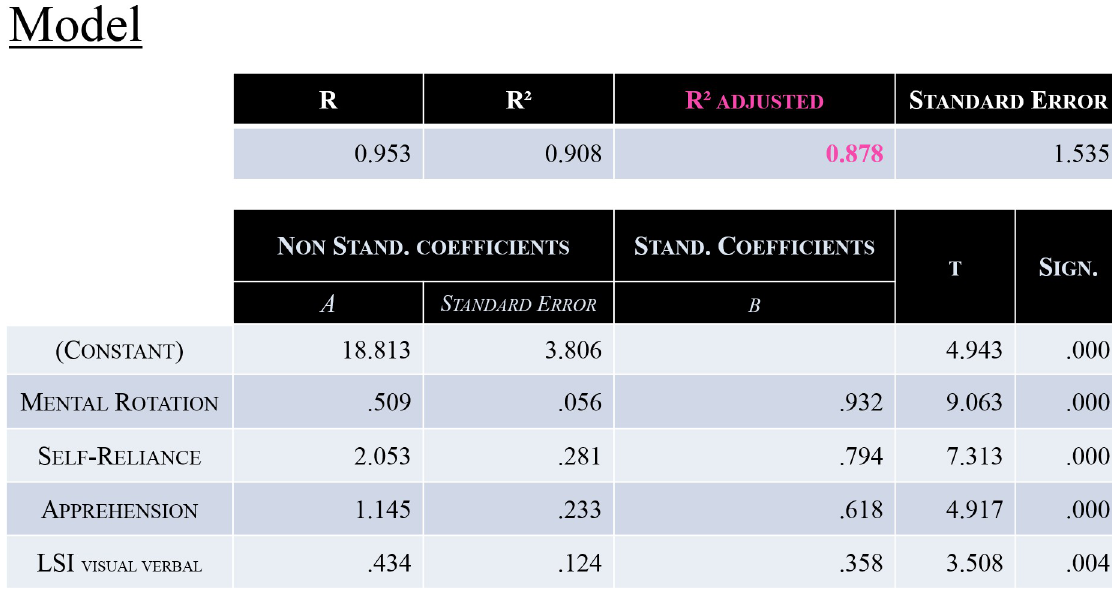
Fig 4. Characteristics of the Model. This model included 4 factors: Mental Rotation, Self-Reliance, Apprehension and the “Visual/Verbal” dimension of the Learning Style. It enabled to explain 87.8% of participants’ MI-BCI performance variance [ R 2